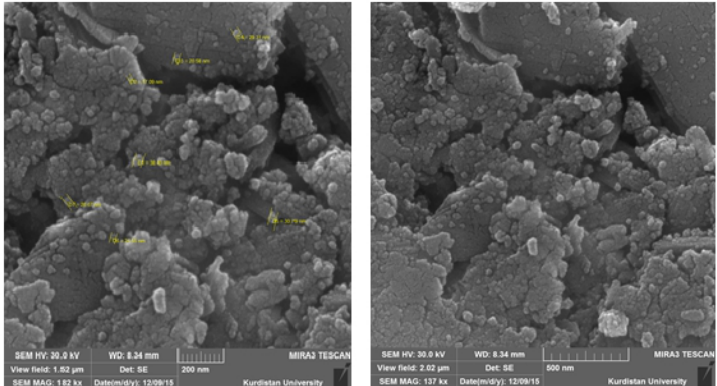
Fig. 4. SEM images of Fe 2 O 3